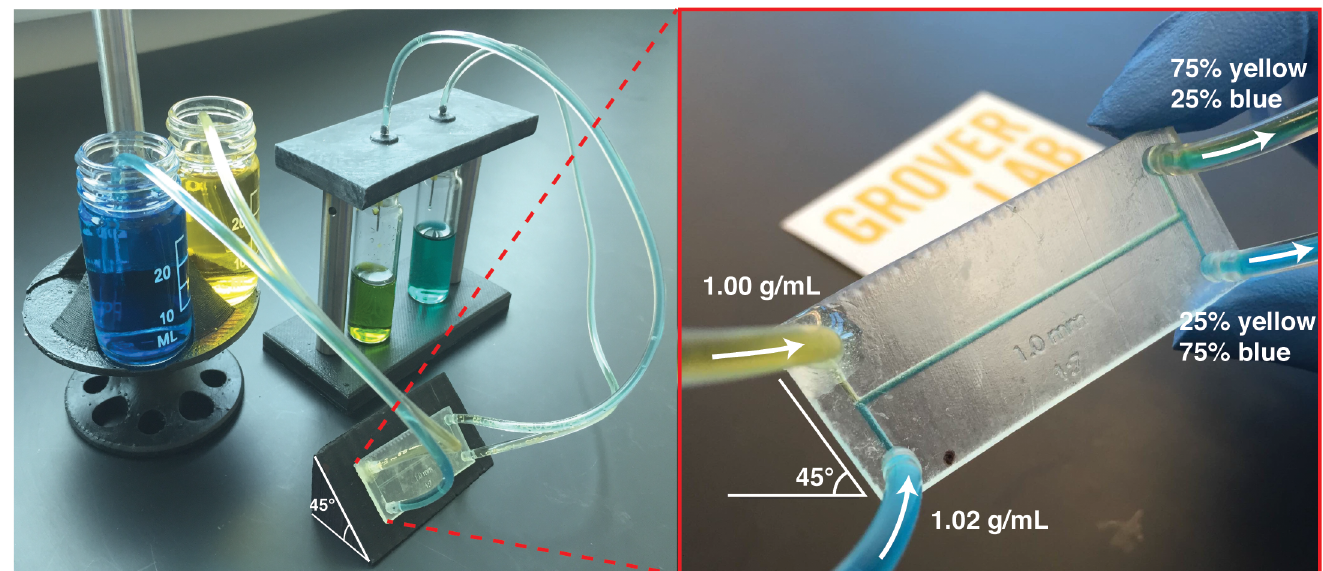
Fig 1. Using the orientation of a microfluidic chip to control the mixing ratio of fluids on-chip. Two fluids (yellow and blue) flow into the chip; the blue fluid includes an additive (sucrose) that makes the blue fluid 2% more dense than the yellow fluid. When the two fluids flow together in the chip, the fluids rotate to orient the more-dense blue fluid toward Earth ’ s gravity. When the channel then splits, the amount of each fluid flowing in each direction is precisely controlled by the angle of the chip. By using this approach, any desired mixing ratio of the yellow and blue fluids can be obtained simply by holding the chip at a certain angle; no off-chip control hardware is